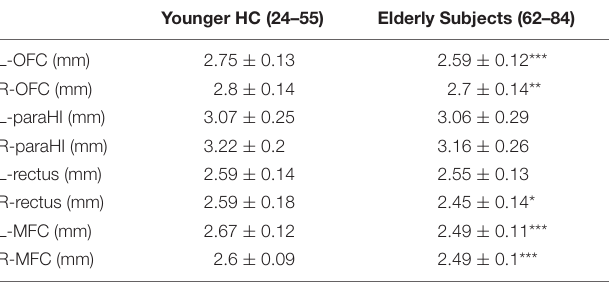
TABLE 2 | Comparison of cortical thickness between young HC and elderly